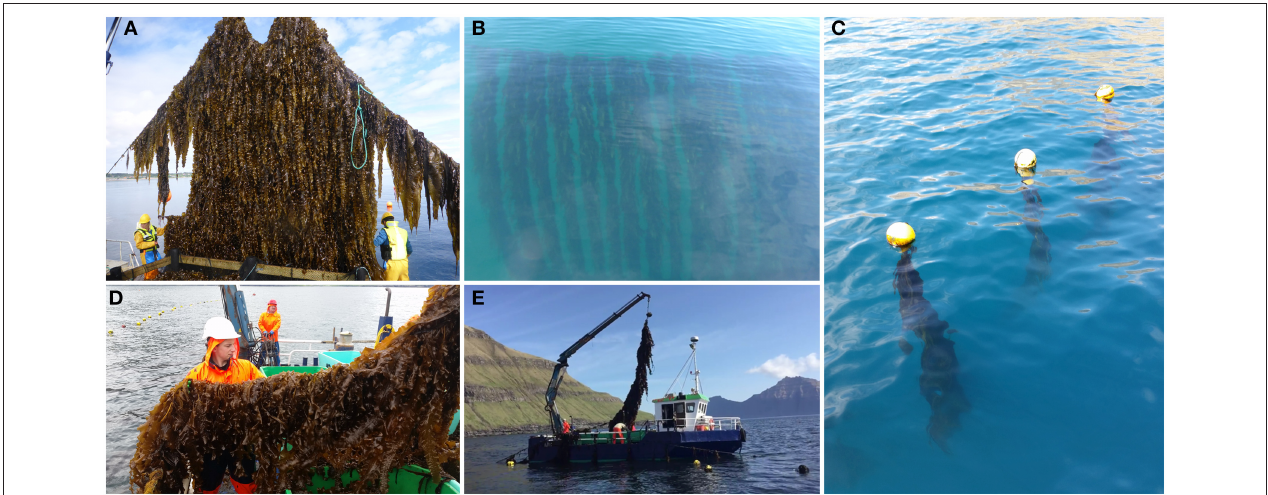
FIGURE 6 | (A–E) Offshore seaweed farms in Norway (Seaweed Carrier) and Faroe Islands (M a croalgal Cultivation Rig—MACR). (A) Harvest of seaweeds growing on the Carrier (upper left); (B) Underwater image of the kelps growing on the Carrier devices (upper centered); (C) Seaweeds hanging perpendicular from the backbone (upper right). (D,E) Harvest of Saccharina latissima on board of the vessel Tongul (lower left and centered) [Images (A,B) with permission of SES , Norway, and the publisher modified after (Buck et al., 2017b); (C–E) with permission of Ocean Rainforest Sp/F , Faroe